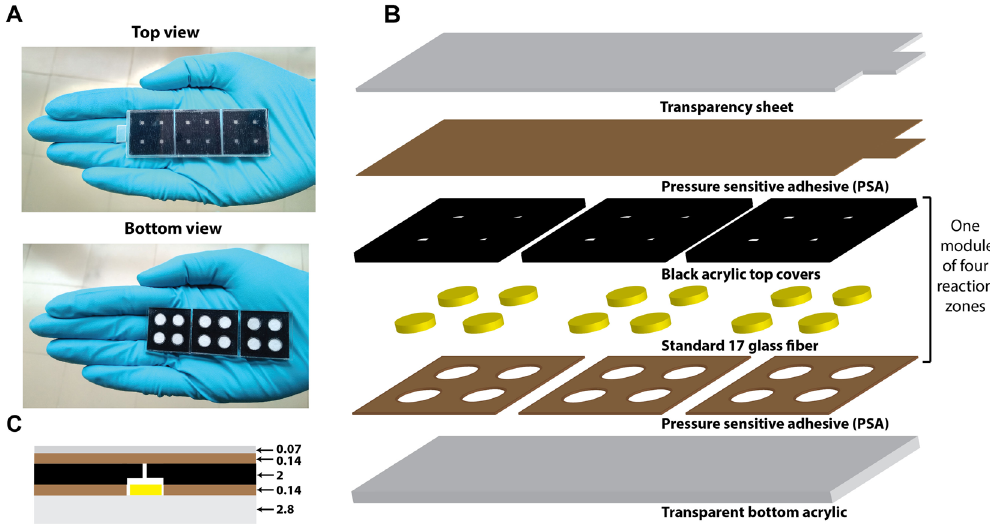
Figure 1. FLIPP-NAAT design. ( A ) Top and bottom view of the fabricated device ( B ) Schematic of the layer- by-layer assembly of the device. ( C ) Schematic of front view of device demonstrating the position of paper (yellow) between the bottom acrylic (grey) and the engraved top acrylic (black). The color of the materials has been kept same as in ( B ) and thickness of each layer is marked in